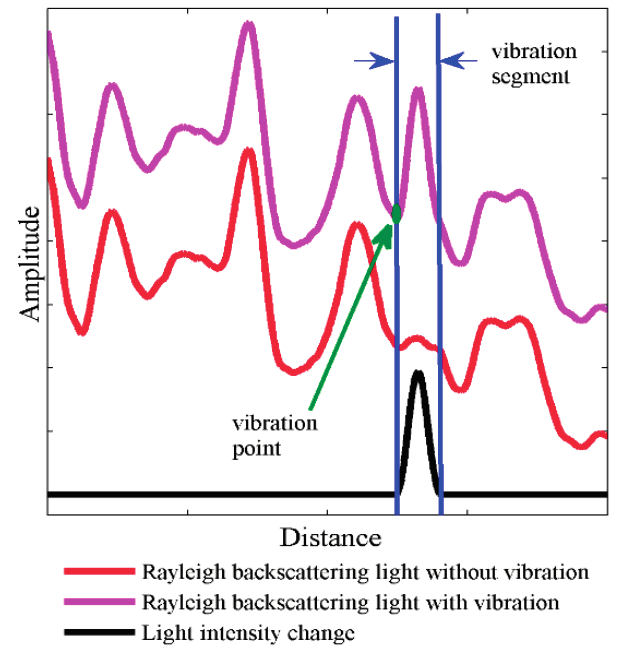
Figure 2. The impact of vibration to the Rayleigh backscattering trace and the relationship between the vibration point and the vibration segment.